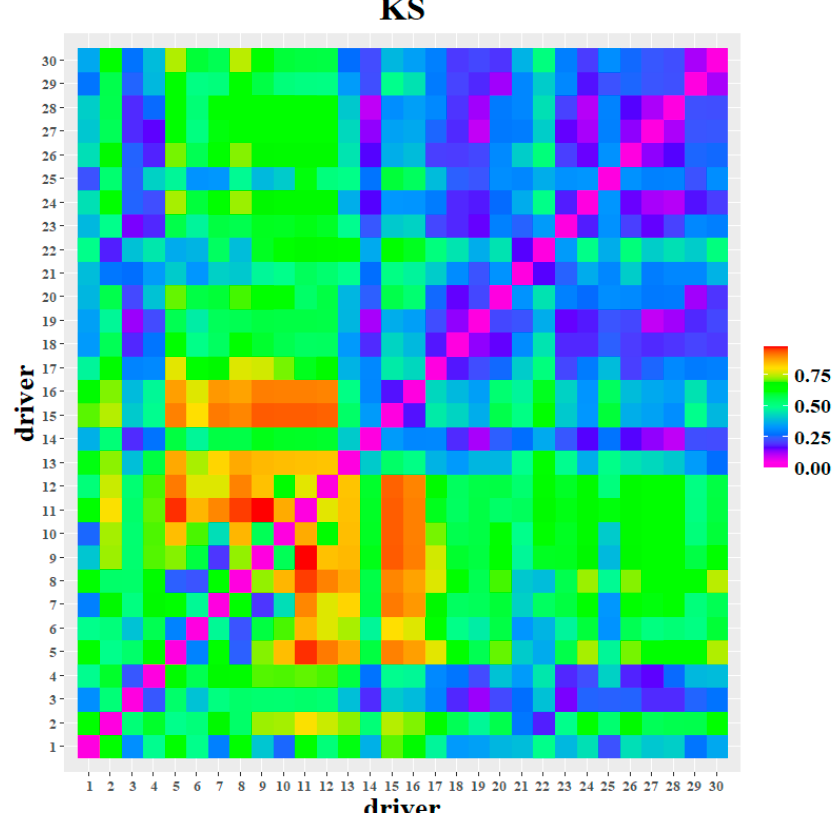
Figure 6. KS test of the driving behaviour semantics between the drivers.